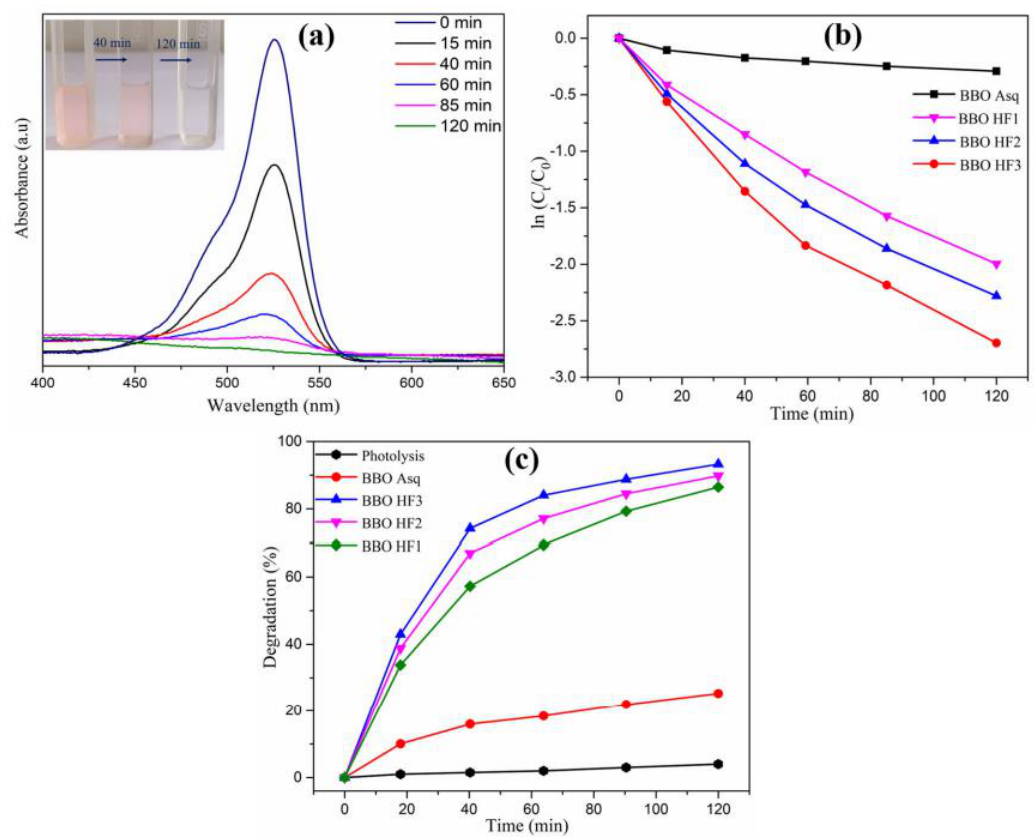
Figure 11. ( a ) Absorption spectra of Rh 6G degradation for BBO HF 3 glass sample. ( b ) Photodegradation curves of as-quenched and HF − etched glass samples. ( c ) Degradation percentage of as-quenched and HF − etched glass samples. Reprinted with permission from Ref. [112].